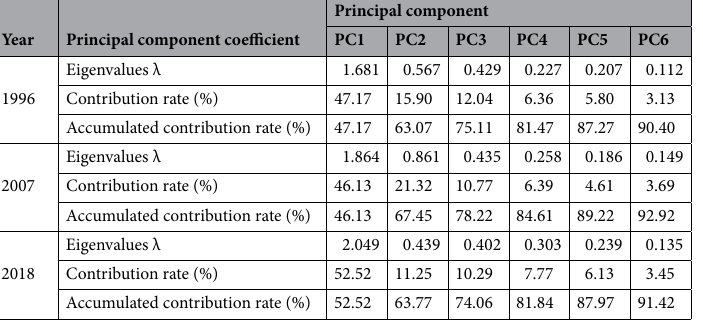
Table 3. Eigenvalue, contribution rate, and accumulated contribution rate of each principal component.